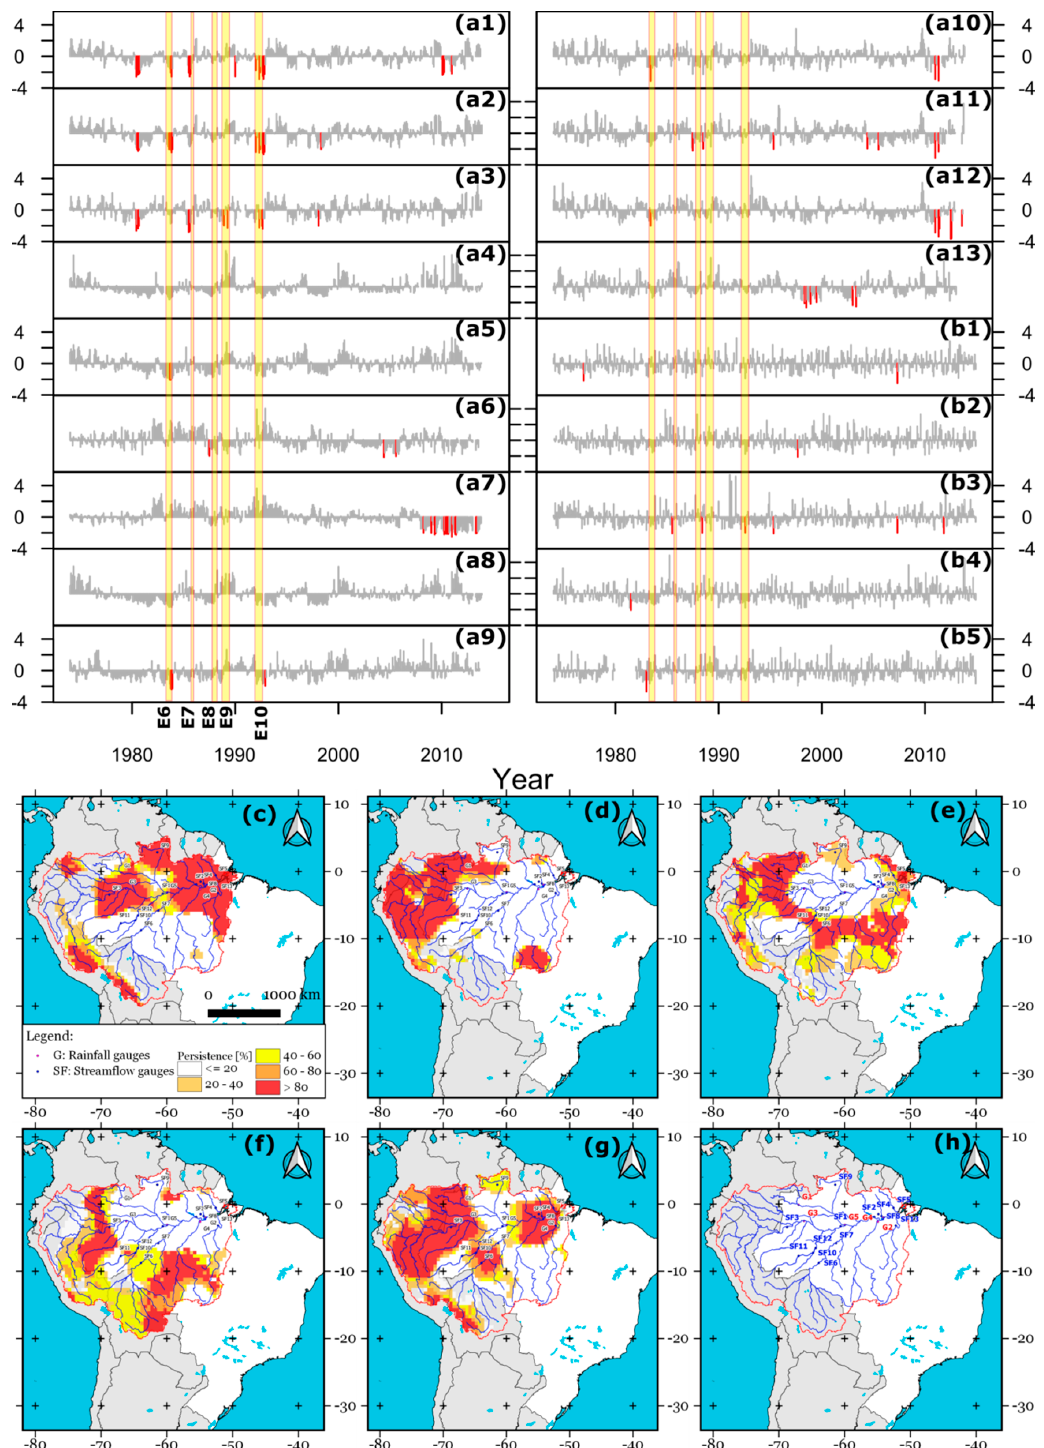
Figure 8. The monthly streamflow anomalies [m 3 /s] at the streamflow gauges shown in ( h ) as: SF1( a1 ), SF2( a2 ), SF3( a3 ), SF4( a4 ), SF5( a5 ), SF6( a6 ), SF7( a7 ), SF8( a8 ), SF9( a9 ), SF10( a10 ), SF11( a11 ), SF12( a12 ), and SF13( a13 ). The monthly rainfall anomalies [mm/month] at the rainfall gauges shown in ( h ) as: G1( b1 ), G2( b2 ), G3( b3 ), G4( b4 ), and G5( b5 ). The temporal persistence of drought conditions [%] during the occurrence of the SPEI12-based extreme drought events: E6( c ), E7( d ), E8( e ), E9( f ), and E10( g ). The spatial distribution of the streamflow [blue] and rainfall [red] gauges is shown in ( h ). The month of start and end for each event is shown in panels ( a1 ) to ( b5 ). The negative anomalies less than -2 in panels ( a1 ) to ( b5 ) are shown with red bars. Base period for the calculation of anomalies: 1974-2013.